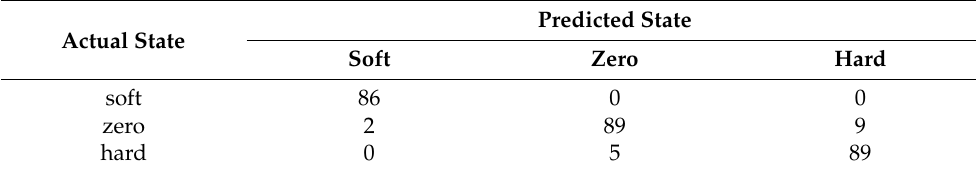
Table 3. Confusion matrix of the prediction